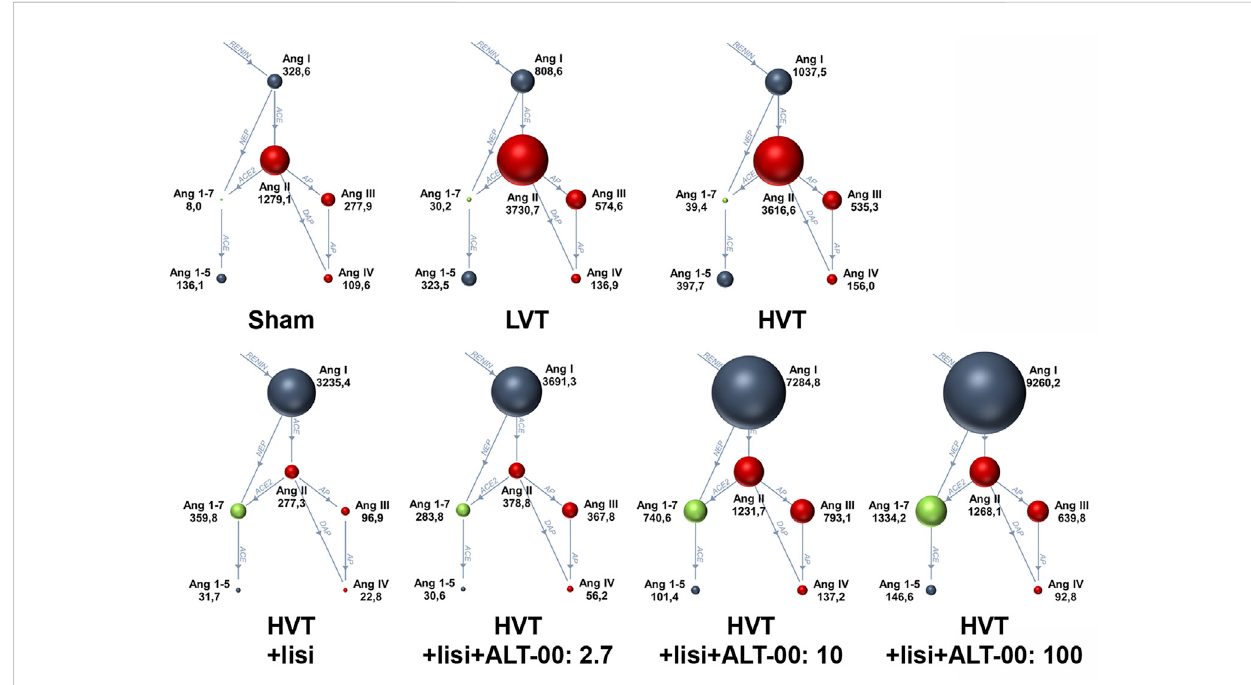
FIGURE 5 Renin-angiotensinsystemFingerprintsfromequilibriumanalysisofplasmasamplesofeachexperimentalgroup.Themedianplasmaconcentrations of angiotensin metabolites in pmol/L in the RAS Fingerprints correspond to the sphere sizes, n = 7/group. Ang, Angiotensin; LVT, low tidal volume; HVT, high tidal volume; lisi, lisinopril, dose levels of ALT-00 in µg/kg/min.